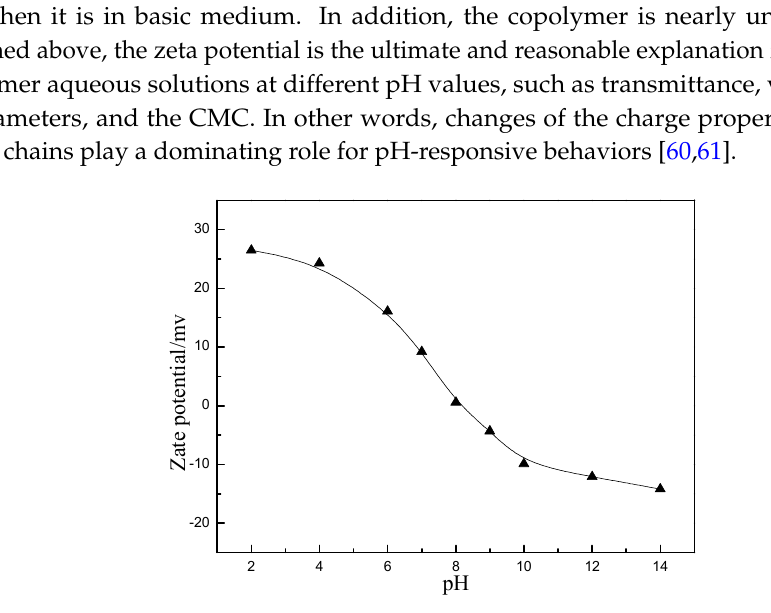
Figure 6. Zeta potentials of P2 aqueous solution (1.5 mg·mL − 1 ) versus pH at 25 °C.